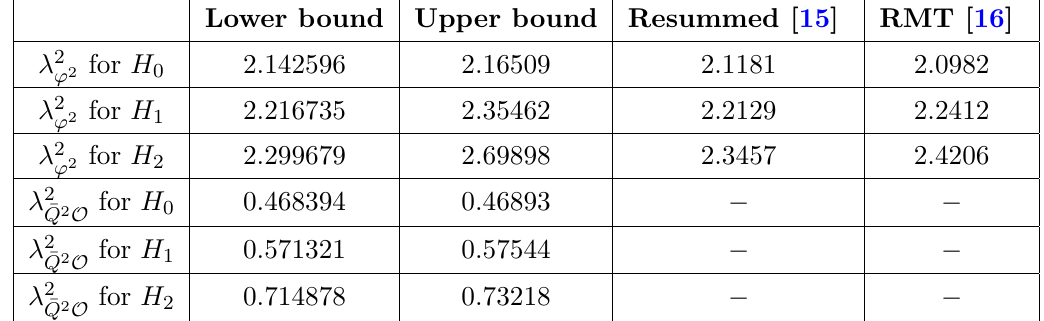
− − Table 7 . Upper and lower bounds on the OPE coefficients of operators ϕ 2 and ¯ Q 2 O in ϕ × ϕ , where ϕ is the highest weight of a chiral multiplet. The parameters ∆ ϕ and c are fixed to the known values of the rank-one Argyres-Douglas theories in table 1. All bounds have been obtained at Λ = 50 . In the rightmost columns we compare with the values computed by resuming an expansion in 1 /r to all orders [15], and using Random Matrix Theory in